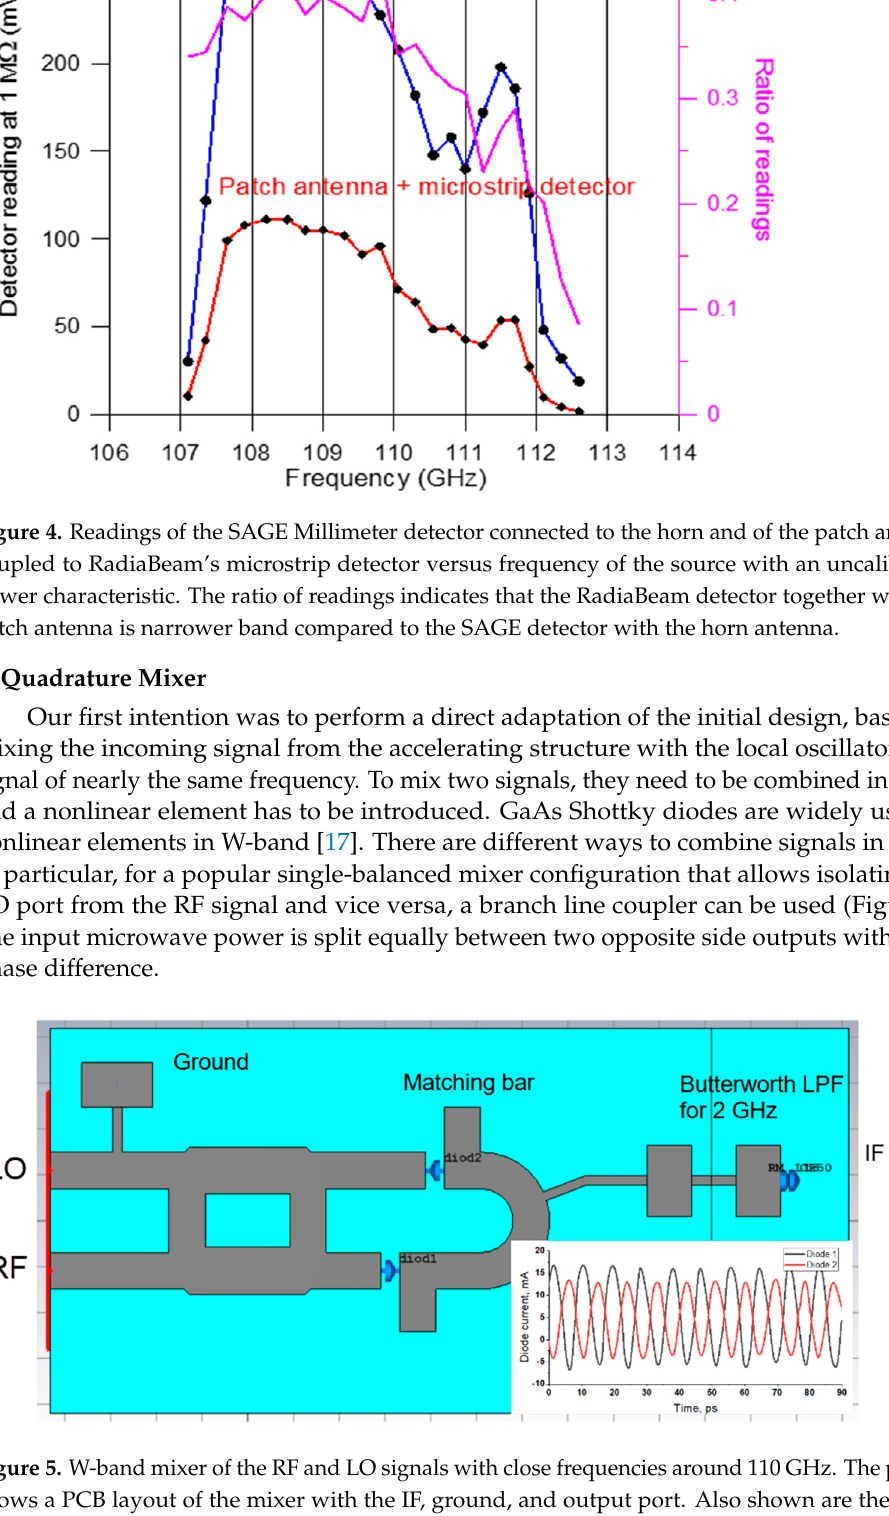
Figure 5. W-band mixer of the RF and LO signals with close frequencies around 110 GHz. The pic- ture shows a PCB layout of the mixer with the IF, ground, and output port. Also shown are the diode currents induced by the 110 GHz LO signal, which are perfectly in the anti-phase. The IF output is attached to the area of zero electric field, so that it does not pick up the high frequency radiation. Two diodes are required for the balanced mixer configuration to work. The diodes’ currents induced by the LO or RF waves must be either in phase or in the anti-phase. A quarter wavelength longer upper microstrip line to the diode provides additional 90° phase difference to the existing 90° phase difference imposed by the branch line coupler